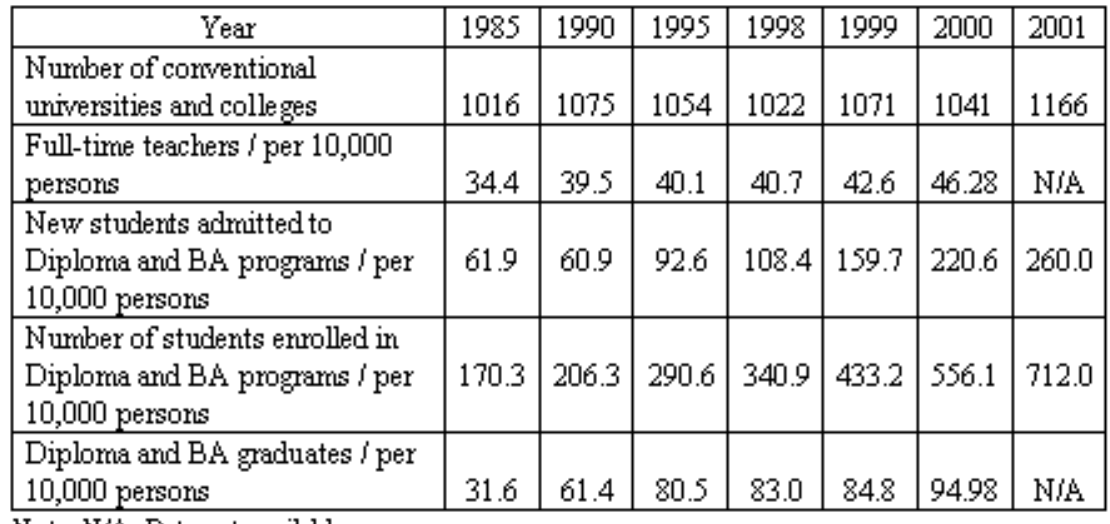
Table 3: Development of General Higher Education in China, 1985 -